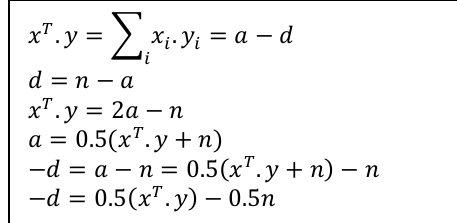
Algorithm 1. Calculating hamming distance between two samples in Hamming Neural Network .